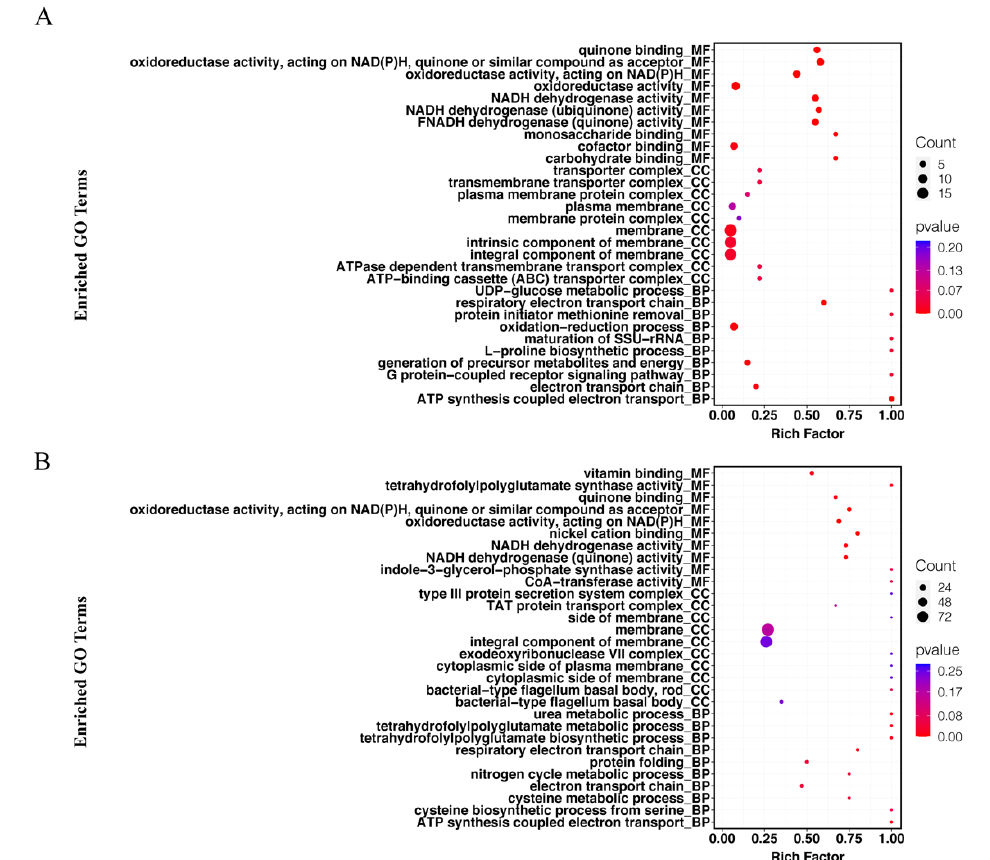
Figure 6. Analysis of GO enrichment for H. pylori 3192 biofilm under different treatments. Top 10 GO terms in the cellular component (CC), molecular component (MF), and biological process (BP) are shown. Rich factor refers to the ratio of DEGs enriched in the pathway to the number of genes annotated. The greater the value is, the higher the enrichment degrees. The size of the solid circle represents the number of DEGs enriched in this pathway, and the color represents the significance of enrichment. FIC group: 1 × FIC of AMX and CLR, CF7 group: 6.25% CFS of 10 7 CFU/mL L. salivarus LN12 in combination with 1 × FIC of AMX and CLR, CF9 group: 6.25% CFS of 10 9 CFU/mL L. salivarus LN12 in combination with 1 × FIC of AMX and CLR. ( A ): CF7 group vs. FIC group, ( B ): CF9 group vs. FIC group.